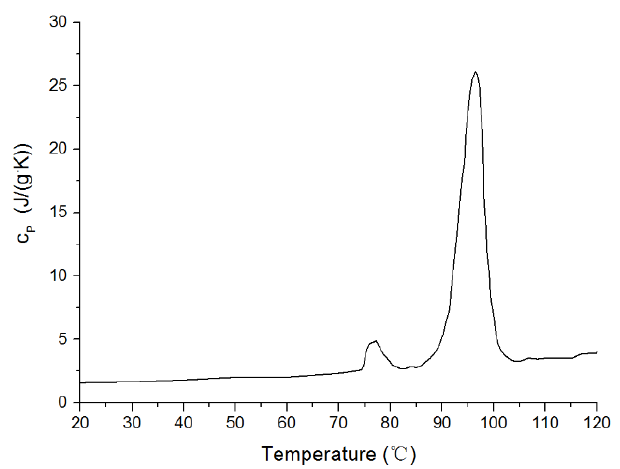
Figure 1. Specific heat capacity of phase change material MNH90.